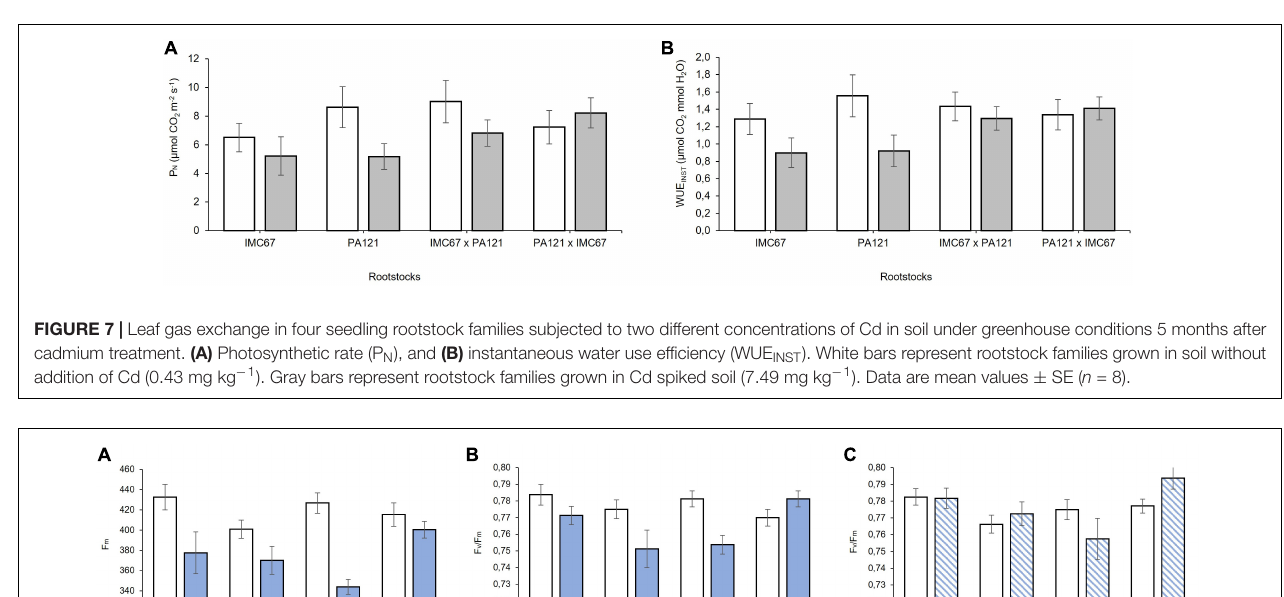
IMC67 OP half-sib progenies, for which there was a reduction of 16.3% in relation to the control. Zn and Mn content decreased in all seedling families subjected to stress by Cd. A significantly higher decrease in the Zn content of 25.8% was observed in